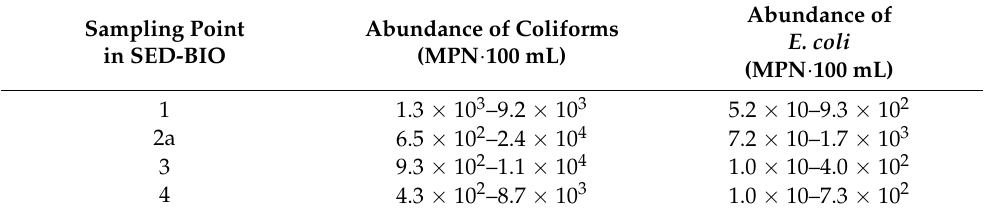
Table 5. The range of abundance of fecal indicator bacteria in different sampling points of the SED-BIO system. MPN—most probable number of cells in 100